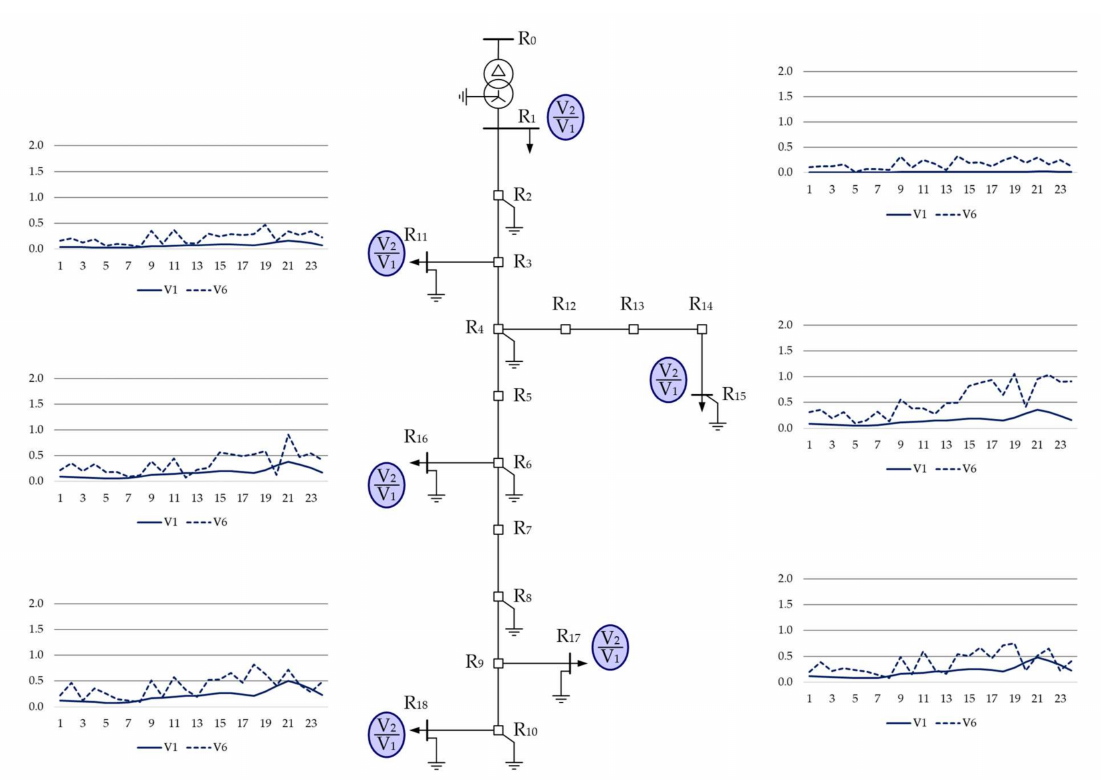
Figure A16. Daily simulation results for variants V1 and V6: negative sequence component of bus voltage